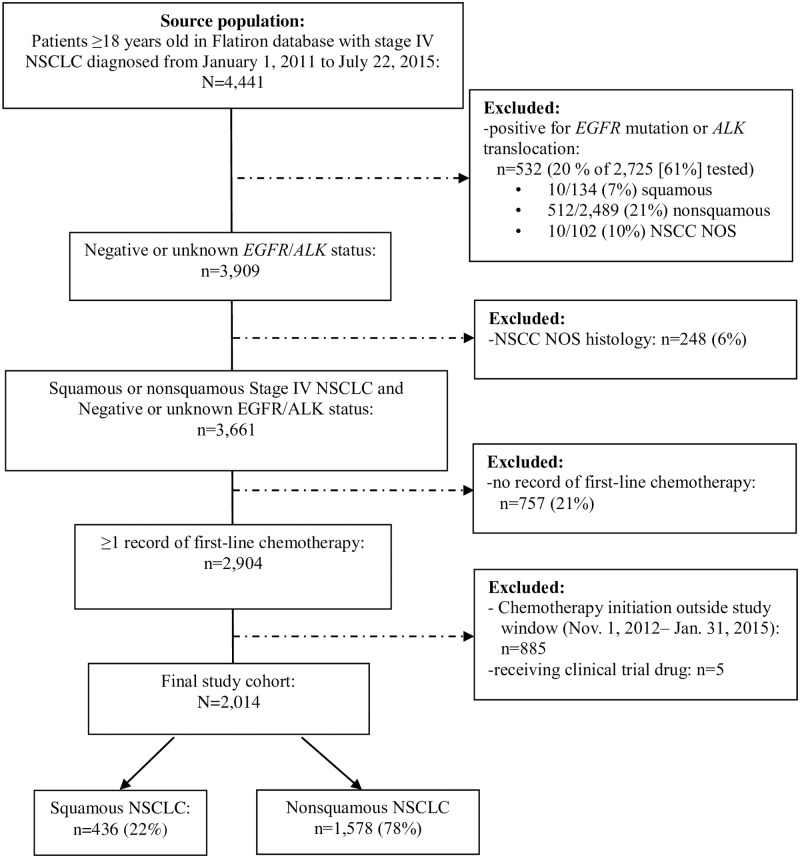
Patient flow chart.Abbreviations: NSCLC, non-small cell lung cancer; NSCC NOS, non-small cell carcinoma, not otherwise specified.